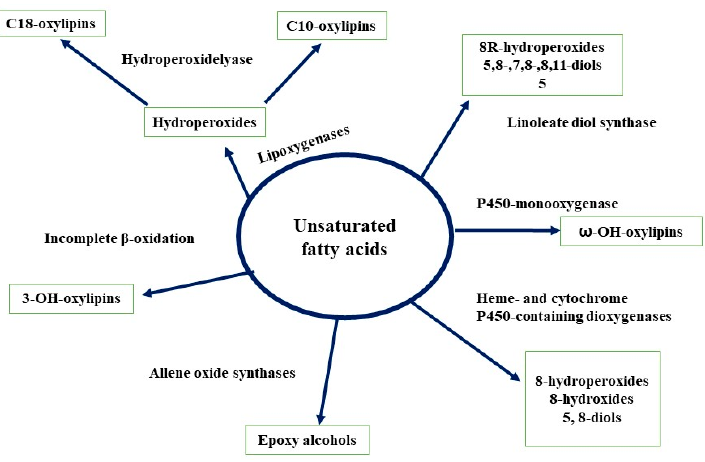
Figure 5. Fungal biosynthesis of oxylipins (adapted from [68]).